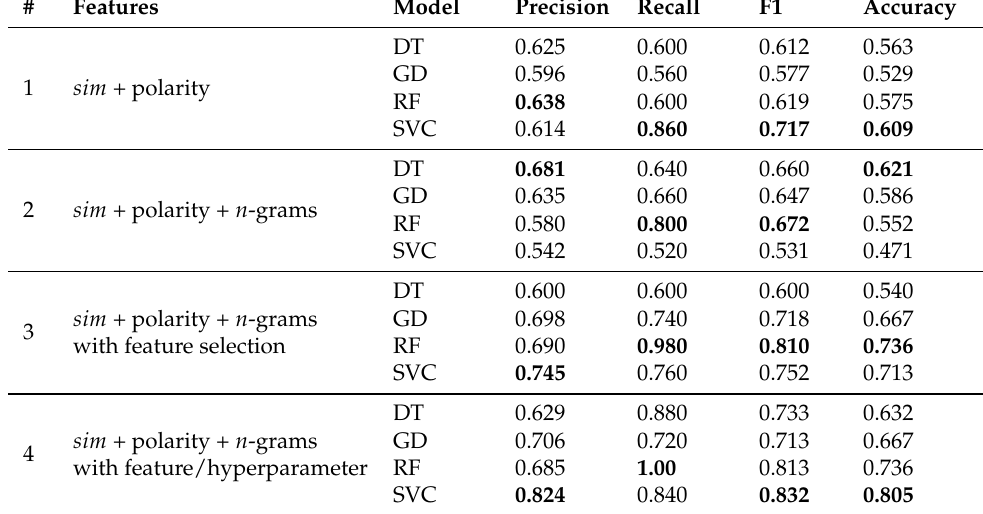
Table 4. Accuracy of different ML models, for diverse combinations of features, to classify users between groups 0 and 1, and precision and recall values for group